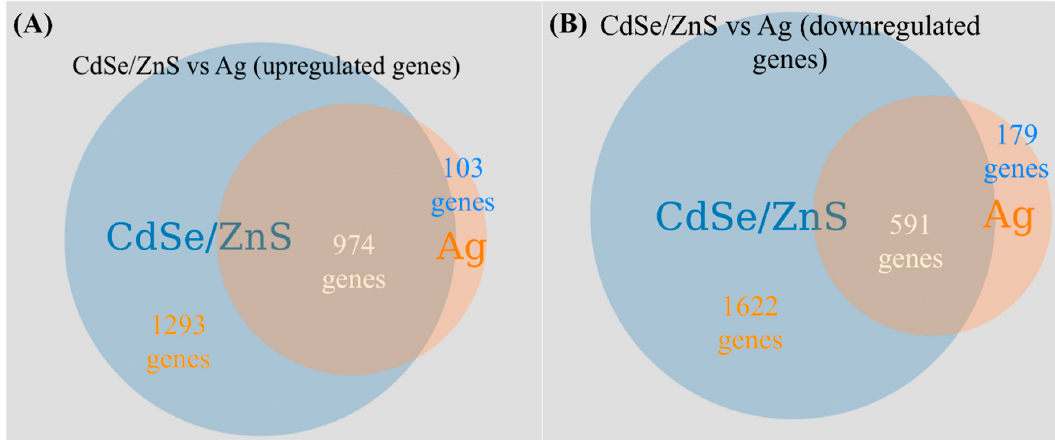
Figure 6. Gene expression Venn-diagram (biovenn.nl) [35] to visualize the shared and separate differentially expressed genes when exposed to CdSe/ZnS-QDs and AgNPs. ( A ) All significant and upregulated genes found in CdSe/ZnS- and Ag-treated cells. The leftmost circle represents the number of genes exposed to CdSe/ZnS, the rightmost circle represents the genes exposed to AgNPs only, and the shared area of the two circles represents the quantity of shared differentially expressed genes in both treatments. ( B ) All significant and downregulated genes. The leftmost circle represents the genes exposed to CdSe/ZnS, the rightmost circle represents the genes exposed to AgNPs, and the middle area represents the same differentially expressed genes in both treatments.